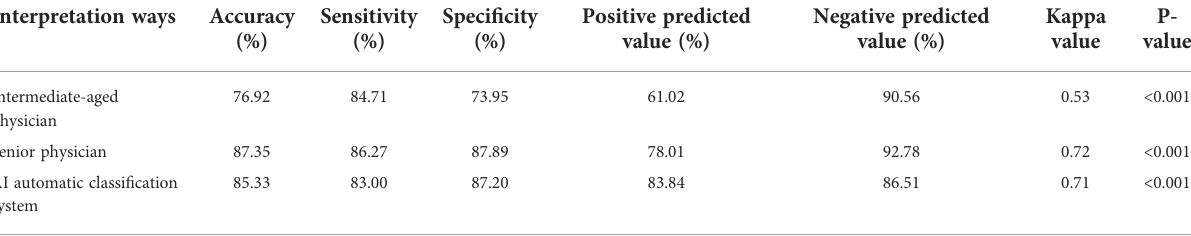
TABLE 3 The differential diagnosis of non-lactating mastitis and malignant breast tumors by both the deep learning – based AI automatic classi fi cation system and intermediate-aged/senior physicians. Interpretation